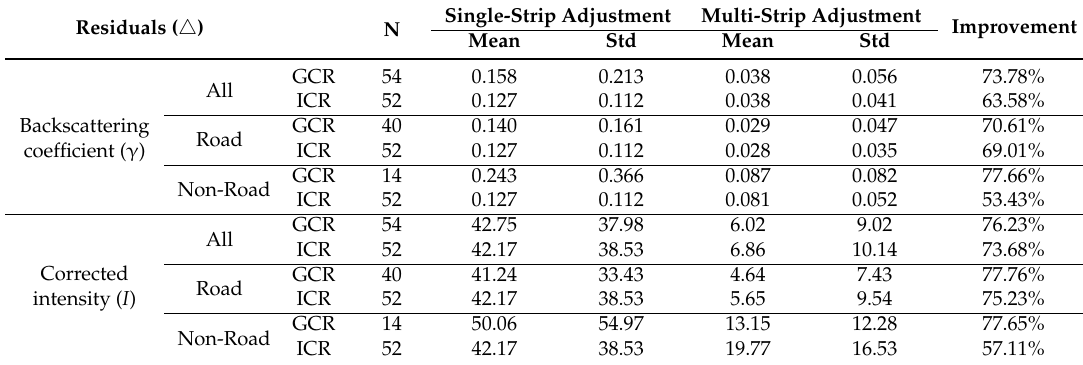
Table 3. Comparison of different materials in multi-strip